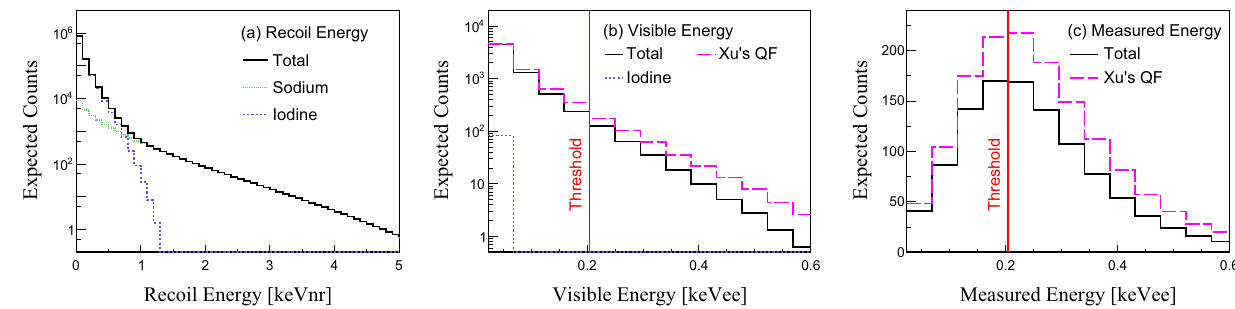
Fig. 24 Expected CE ν NS signals in the NEON experiments for 1year of data taking are presented. a Expected CE ν NS signal rates in recoil energy are presented for sodium (green solid line), iodine (blue solid line), and combined NaI (black solid line). b Visible energy spectra